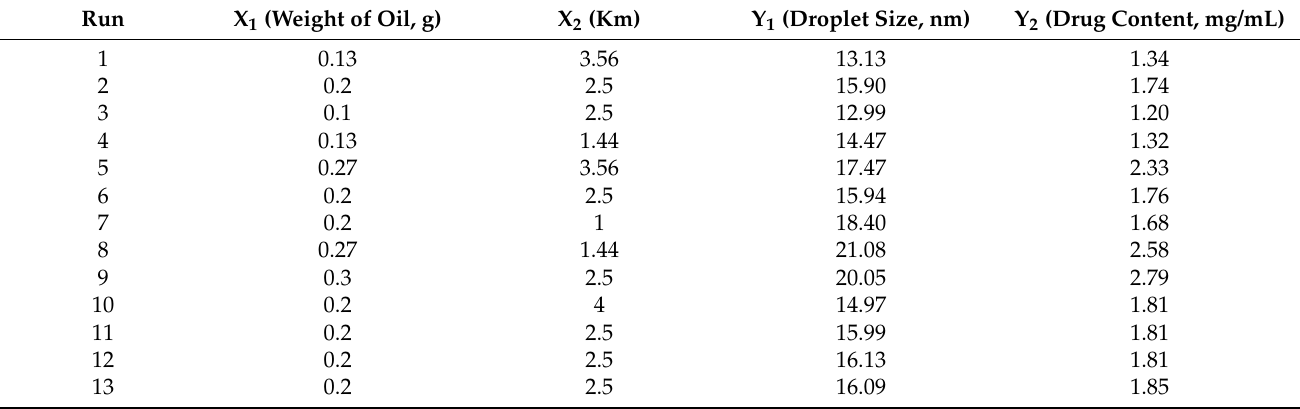
Table 1. The results of central composite